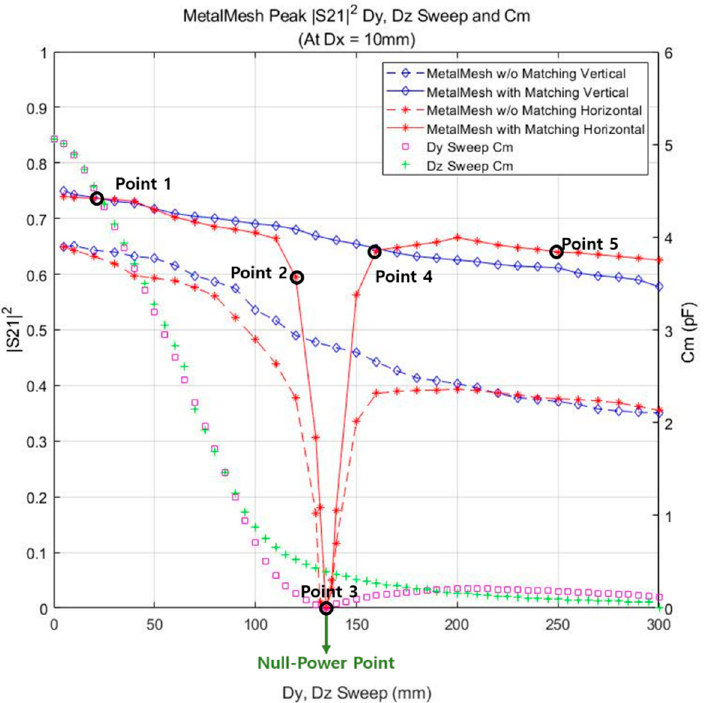
Figure 12. Efficiency and mutual capacitance variation under distance ( 𝐷 (cid:3052) , 𝐷 (cid:3053) ) sweep: 0–300 mm.